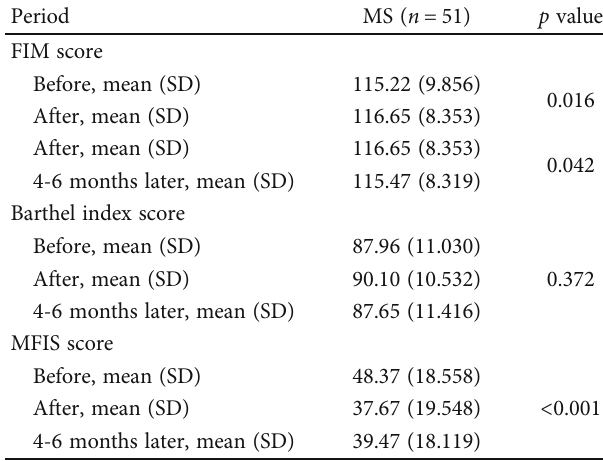
Table 2: Di ff erences in FIM, Barthel Index, and MFIS scores in multiple sclerosis